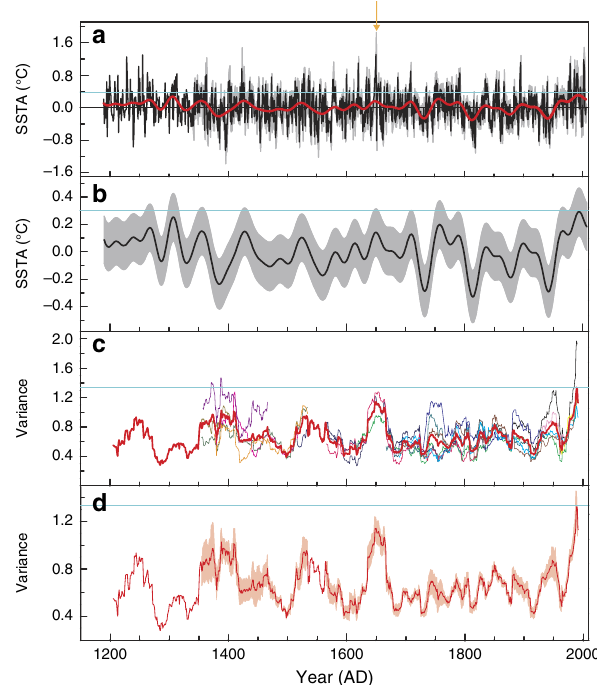
Figure 4 | Composite Taiwan tree-ring d 18 O-based reconstruction of NIN˜O4 sea-surface temperature (SST) anomaly from 1190 to 2007 AD. ( a ) Plot of composite tree d 18 O-based NIN˜O4 SST anomalies (SSTAs) averaged over March–May for each year, calculated with respect to the mean of observed SSTs during the 1950–2007 AD period (black horizontal line), plotted with 31-year low-passed version of the data (red line), and the blue horizontal line indicates the highest 31-year low-passed SST value of the time series. The grey area denotes ± 2 s error bars, based on the statistical reconstruction across overlapping tree d 18 O series 53 . An anomalously high reconstructed SST value in 1651 AD is indicated by an orange arrow. ( b ) Thirty-one-year low-passed value of the composite Taiwan tree d 18 O series shown in a . The grey area denotes ± 2 s smoothed error bars 54 . The blue horizontal line indicates the highest 31-year low- passed SSTvalue of the time series 41 (Methods). ( c ) Time series of 31-year running variance of internnual-scale variability (isolated with a 2–7-year band-pass filter) corresponding to each of the 16 individual raw tree-ring d 18 O time series (thin coloured lines) and the average of these running variance time series (thick red line, for periods where they overlap). ( d ) The red line is the same red line in c and the pink area denotes ± 1 s of the mean. The horizontal blue lines both in c , d indicate the highest 31-year averaged interannual variance value of the time series, centred on 1992